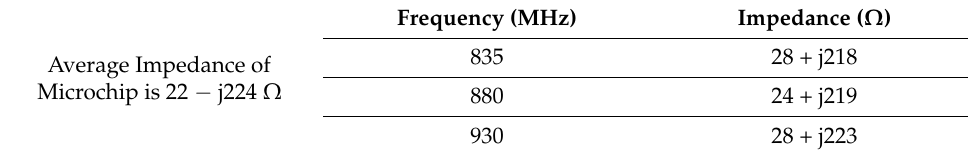
Figure 4. Input impedance (Real and Imaginary) of the proposed Tag antenna ( a ) 840 MHz ( b ) 900 MHz ( c ) 950 MHz. Table 3. Impedance Value of Different Frequencies .